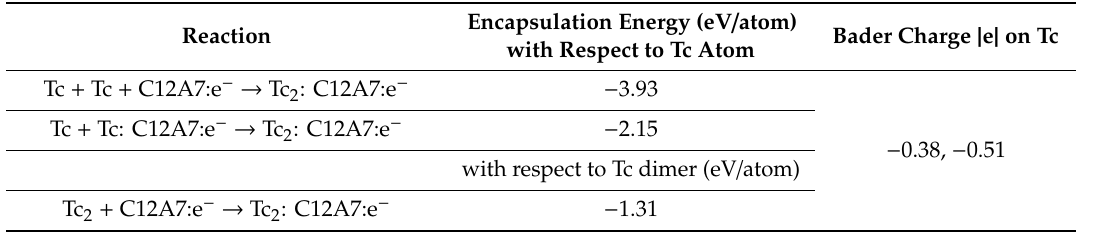
Table 4. Encapsulation energy and Bader charge calculated for the formation of the Tc dimer inside C12A7:e −